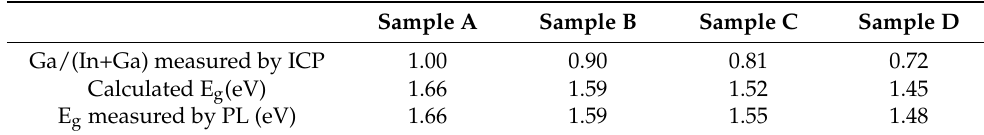
Figure 2. The PL spectra of the CIGS films with different gallium content. Table 2. The Ga/(In+Ga) measured by ICP and the band gap measured by PL. Sample A Sample B Sample C Sample D Ga/(In+Ga) measured by